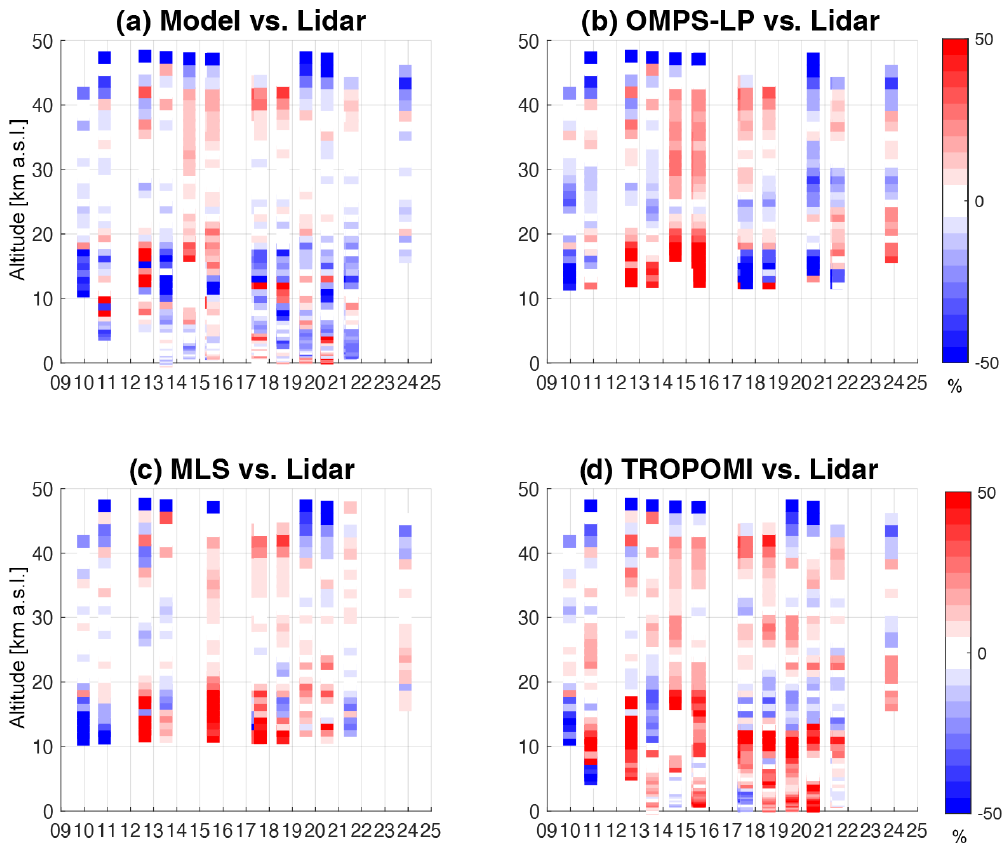
Figure 7. Differences in ozone number densities across all platforms for the TROLIX-19 time period for the model (a) , OMPS-LP (b) , MLS (c) and TROPOMI (d) . The x axis is the day of September